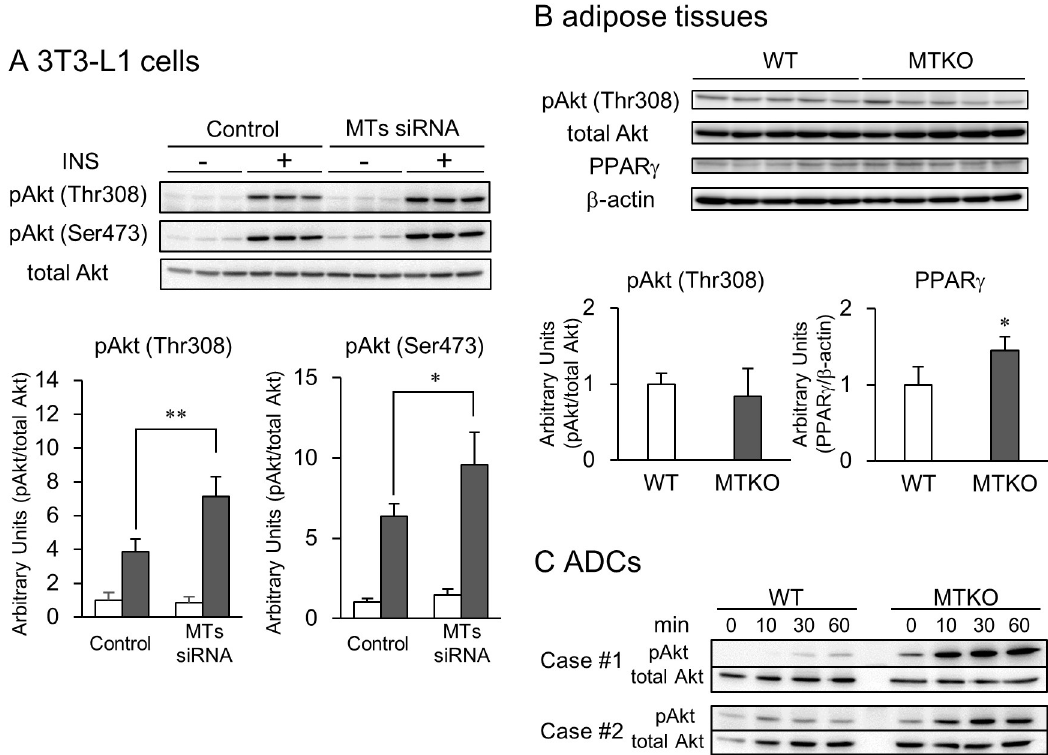
Fig 7. Effect of MT gene silencing and MT knockout on Akt phosphorylation. Cell lysates and tissue extracts were separated on 10% gels using SDS-PAGE. Immunoblotting was performed with the indicatedantibodies. The phosphorylationratios of Akt (pAkt) proteinsor the expressionratios of PPAR γ to β -actinwere calculatedby densitometric analysesof immunoreactive bands. (A) After siRNA pretreatment, the cells were pre-incubated with 1 μ M DEX and 0.5 mM IBMX for 2 h and incubatedin serum-free medium for 1 h. Then, the serum-free medium in the presence or absence of 10 nM insulinwas addedto the cells for 30 min. Open columns are cells untreatedwith insulinand closed columns are cells treated with 10 nM insulin. Data are expressedas the mean ± SD ( n = 3). * and ** represent P values of < 0.05 and < 0.01, respectively.(B) Extracts from the adiposetissue of five-day-old mice were subjectedto electrophoresis on SDS-PAGE gel. Open columnsare WT mice and closed columns are MTKO mice. Data are expressedas the mean ± SD ( n = 5). * represents P values of < 0.05. (C) ADCs derived from the adiposetissues of five-day-oldWT and MTKO mice (two individualsof each genotype, Case #1 and Case #2) were incubatedwith 1 nM insulinin serum-free medium for the